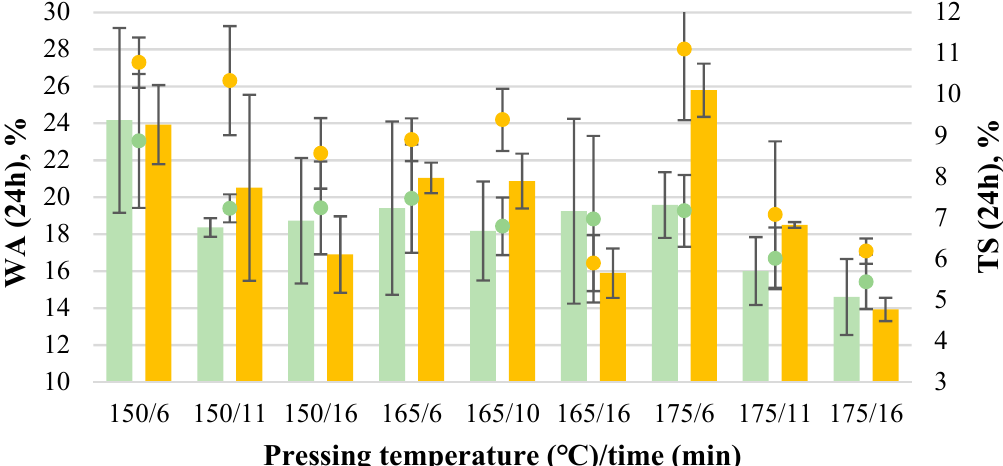
Figure 14. WA and TS of binder-less boards with a density of 1200 kg m − 3 depending on the crop and pressing variables.